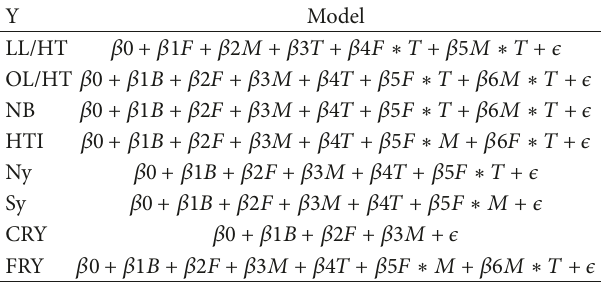
Table 1: Generalized linear mixed models utilized for each of the response